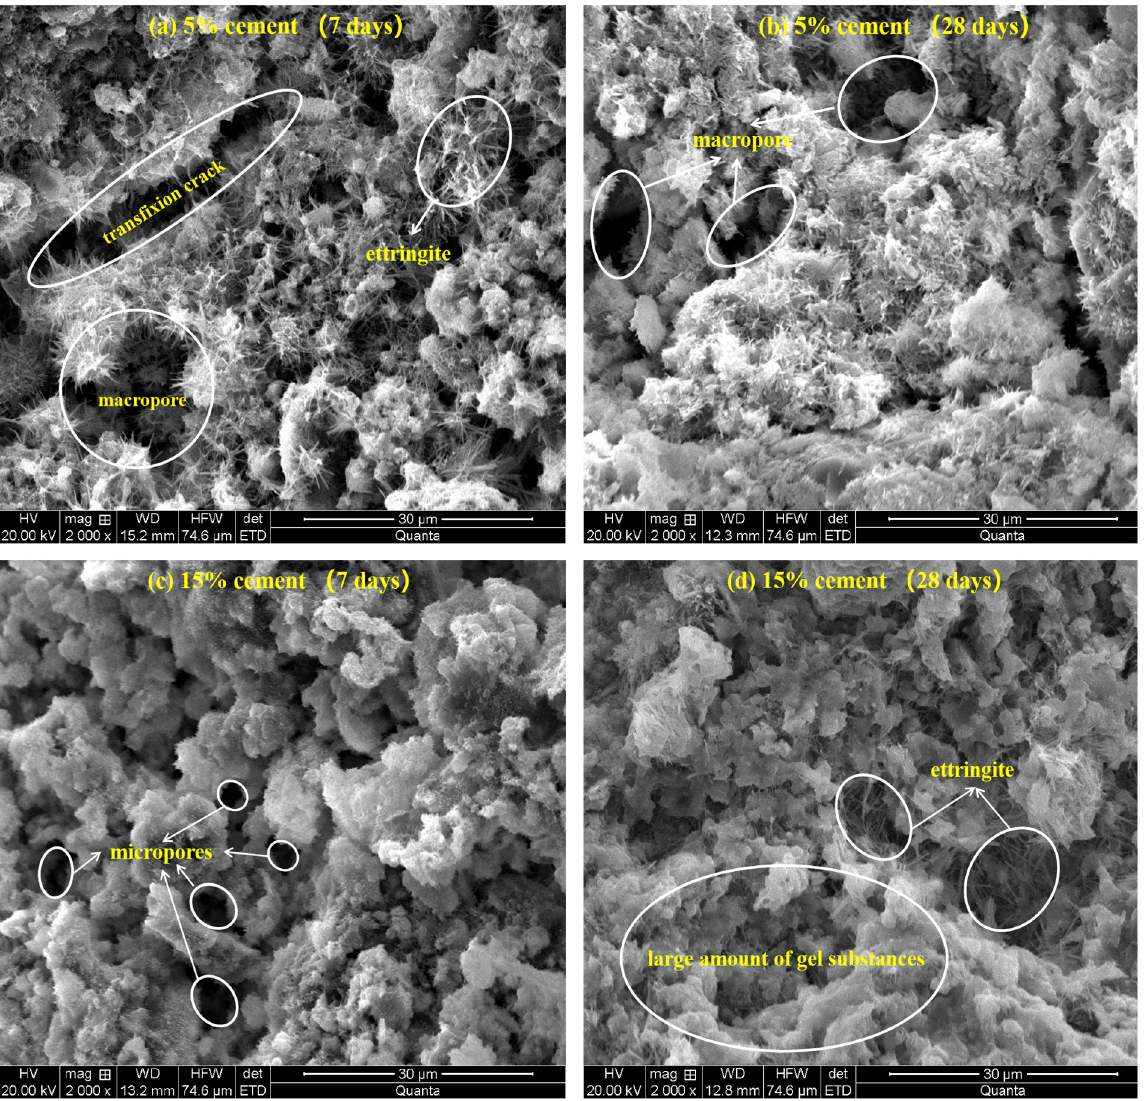
Figure 17. The micromorphology of stabilized specimens: ( a ) 5% cement-7 days, ( b ) 5% cement-28 days, ( c ) 15% cement-7 days, ( d ) 15% cement-28 days.